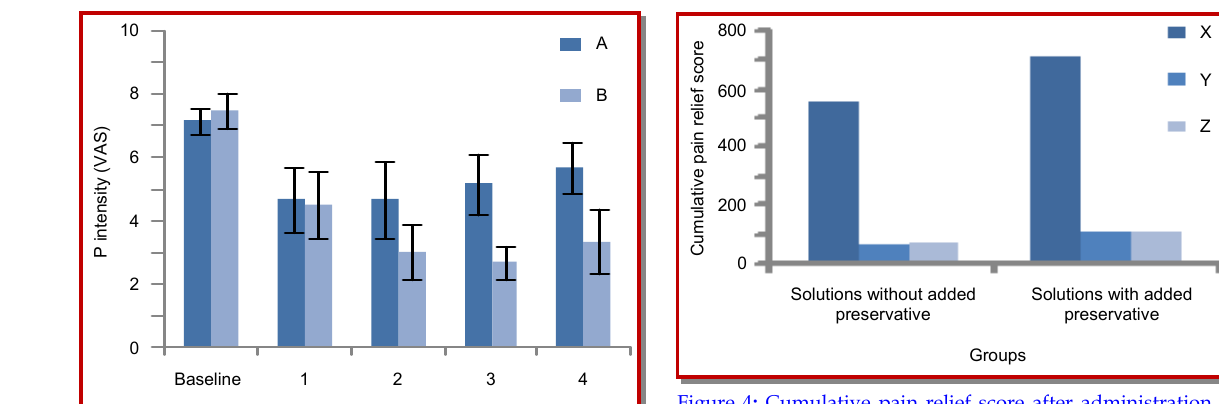
Figure 4 : Cumulative pain relief score after administration of morphine solution prepared from sustained release tablets and injectable formulations with and without added